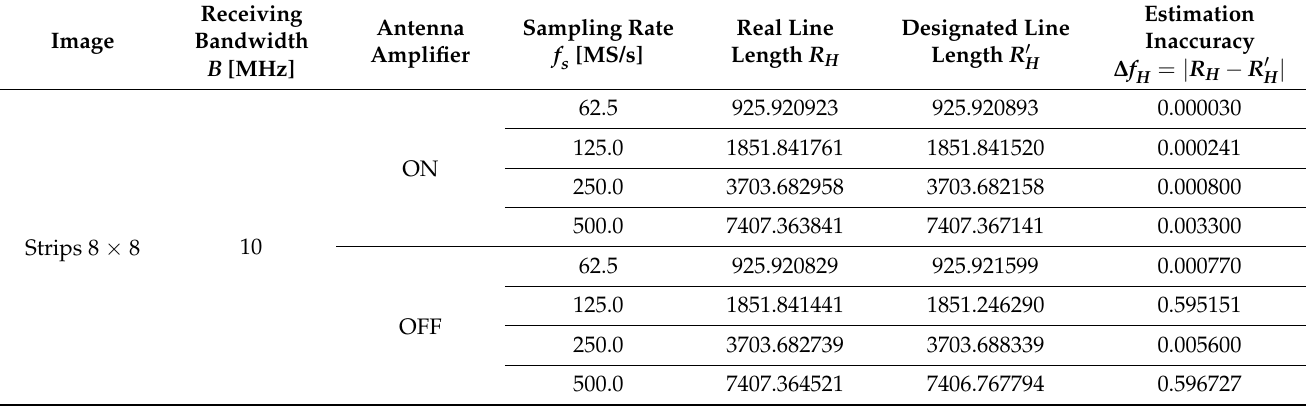
Table 8. Determination of the R H parameter for the reception frequency f o = 102 MHz, in the receiving band BW = 10 MHz, with the antenna amplifier on and off (+ 10 dB )